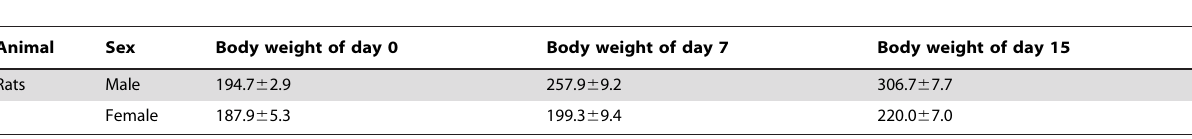
Table 1. Body weight of rat in acute oral toxicity study.